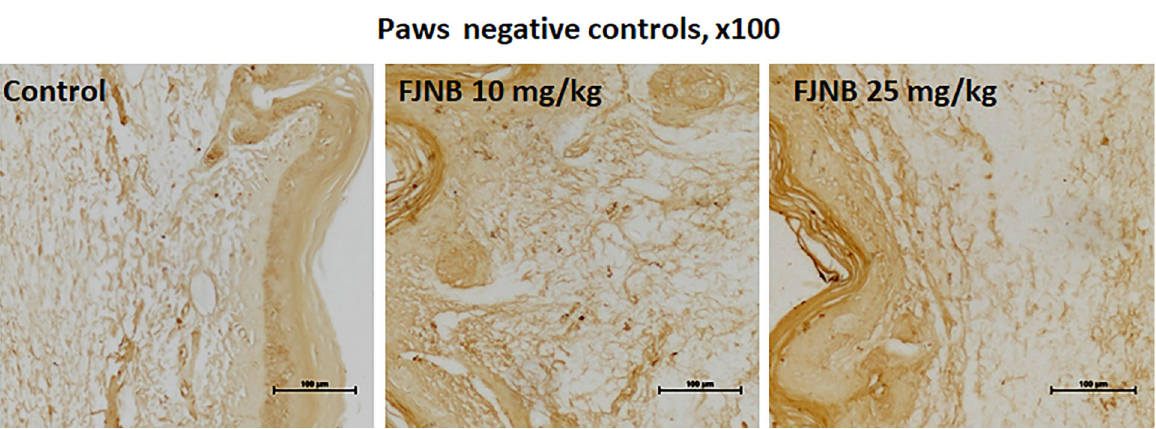
Figure 10. Representative photomicrographs ( (cid:1) 100 magni fi cation, scale bar, 100 m m) of negative controls (in fl amed paws, after the formalin test) of the three tested groups. The immunohistochemical assays were performed in the absence of the primary